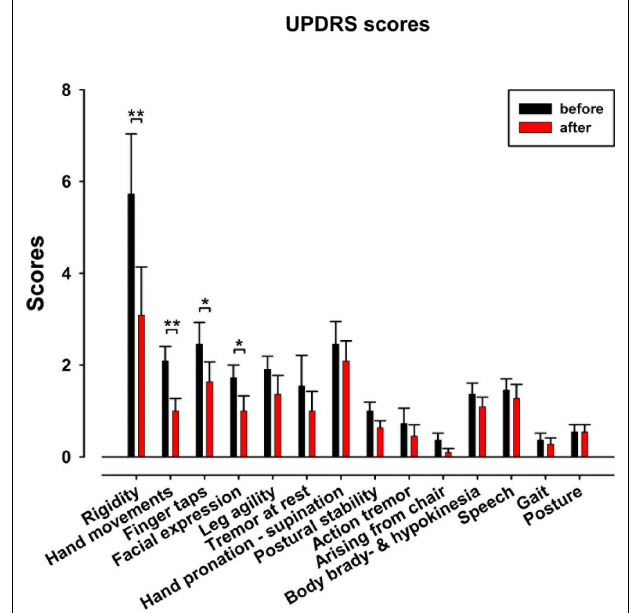
FIGURE 1 | Unified Parkinson disease rating scale III motor scores before (black) and after (red) the dance class for the 11 patients. Note the significant improvement in rigidity, hand movements, finger taps, and facial expression.